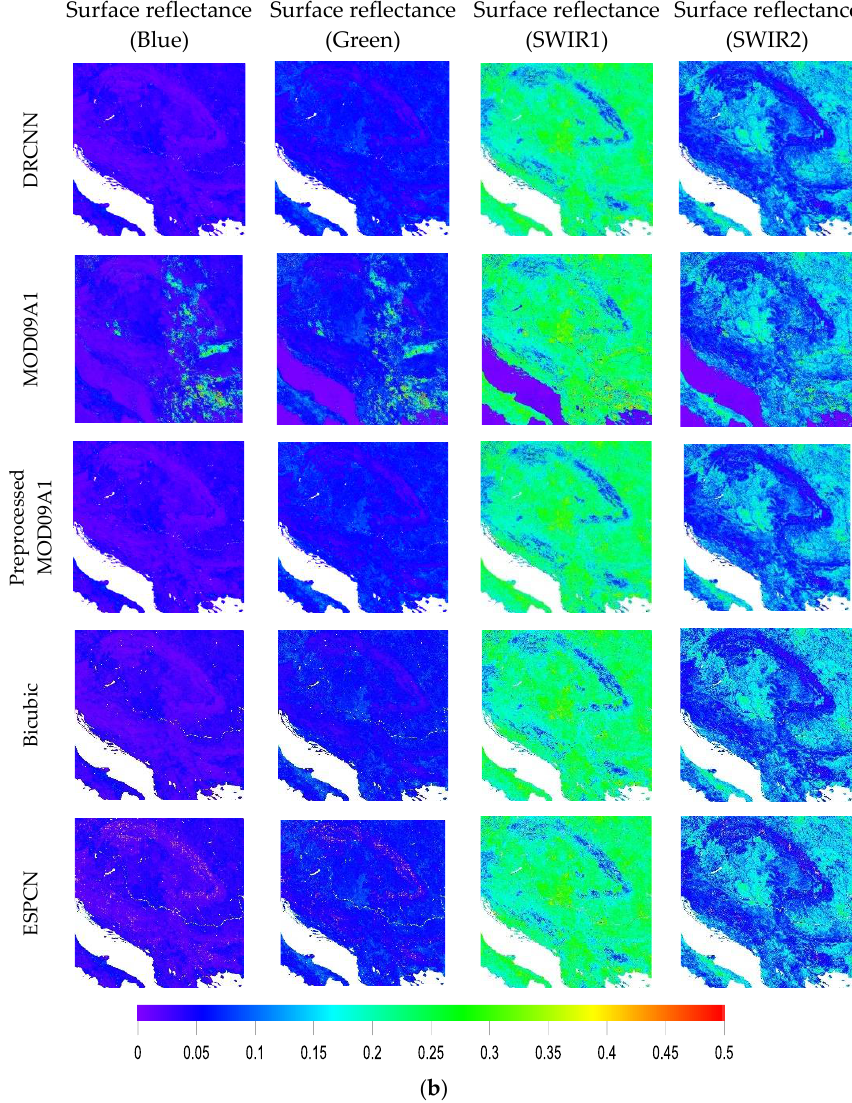
Figure 10. Comparisons of the downscaled surface reflectance in the blue, green, SWIR1 and SWIR2 bands from the DRCNN with the surface reflectance in the corresponding bands from the MOD09A1 product and the preprocessed MOD09A1 product and the surface reflectance in the corresponding bands downscaled by the bicubic interpolation method and the ESPCN method on day 265 in 2015 at ( a ) h26v04 and ( b ) h19v04. Time series of the downscaled surface reflectance from the DRCNN and the sur- face reflectance from Landsat 7 in the blue, green, SWIR1 and SWIR2 bands in 2002 at the Zhangbei, Collelongo, Barrax, Counami, Larose and Camerons sites are shown in Figure 11. In these figures, the blue dot represents the surface reflectance from Landsat 7 after projection conversion and quality control, and the red dot represents the downscaled surface reflectance from the DRCNN. The downscaled surface reflectance from the DRCNN achieved excellent agreement with the surface reflectance from Landsat 7, especially in the blue and green bands for the entire year at these